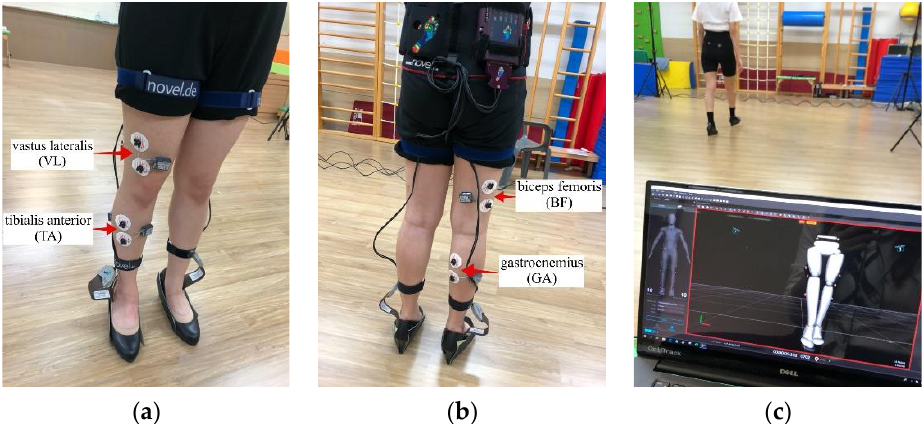
Figure 3. Scenes of the experiment: ( a , b ) System for measuring the pressure inside the Pedar-X shoes and the EMG electrode; and ( c ) the 3-dimensional movement analysis system (Optitrack 3D Motion Capture System).